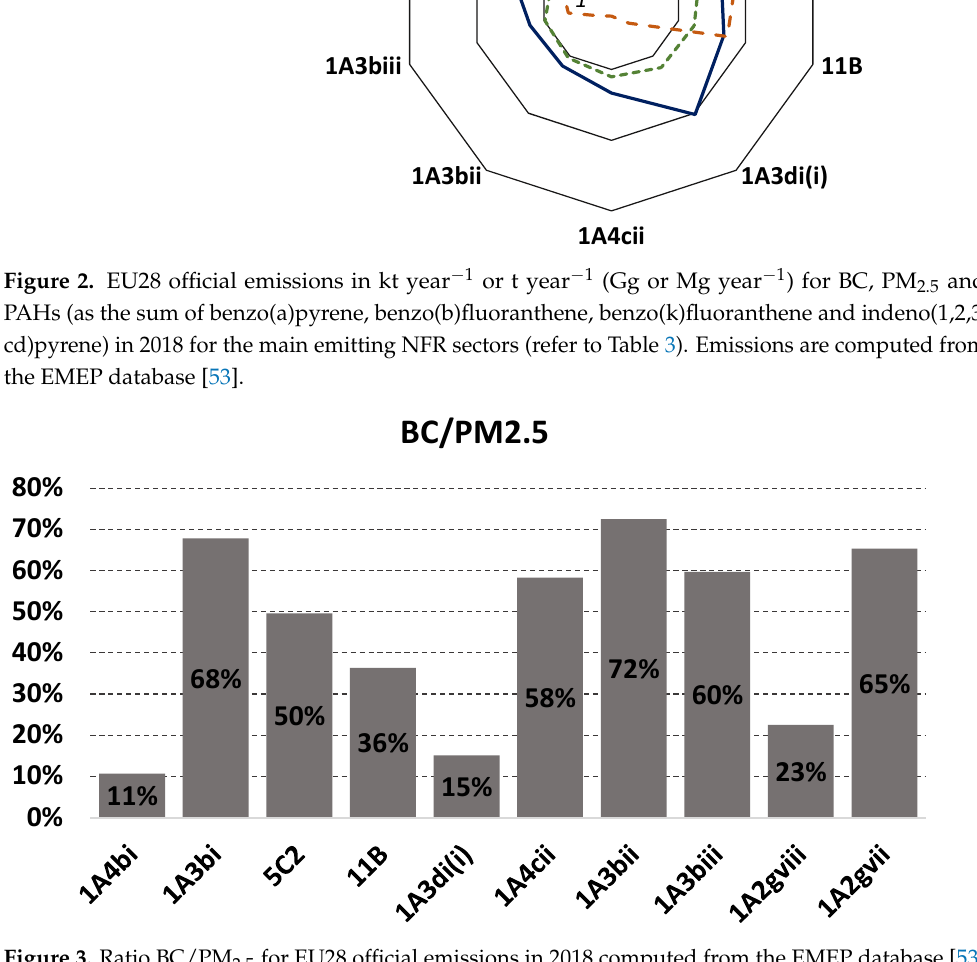
Figure 3. Ratio BC/PM 2.5 for EU28 official emissions in 2018 computed from the EMEP database [53] for the main emitting NFR sectors (refer to Table 3).